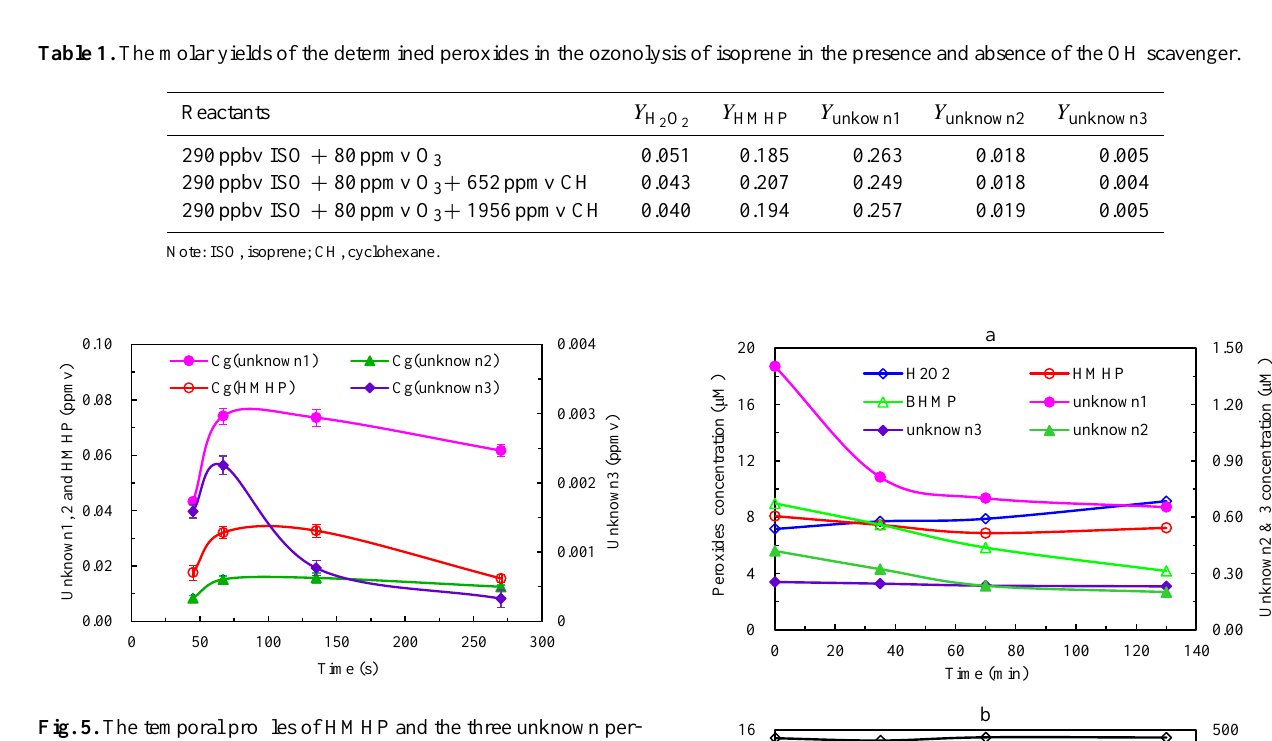
Fig. 5. The temporal profiles of HMHP and the three unknown per- oxides at 5% RH.